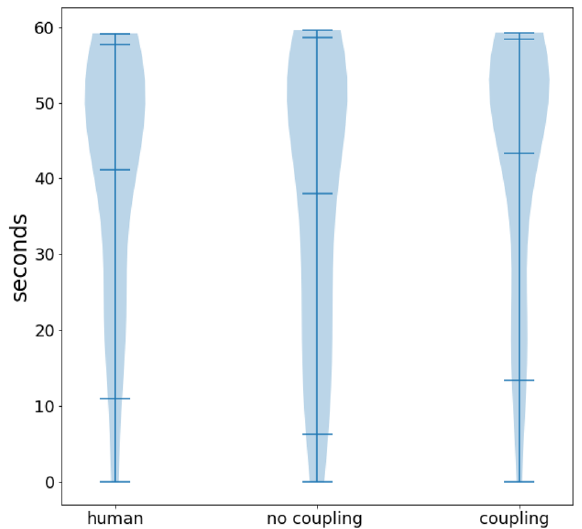
Figure 3. Amount of time participants reported the feeling of synchrony. The violin plots show the distribution in the amount of time that each participant reported feeling in synchrony for each condition. The mean, 0.95 confidence intervals, and the extreme values are drawn as horizontal